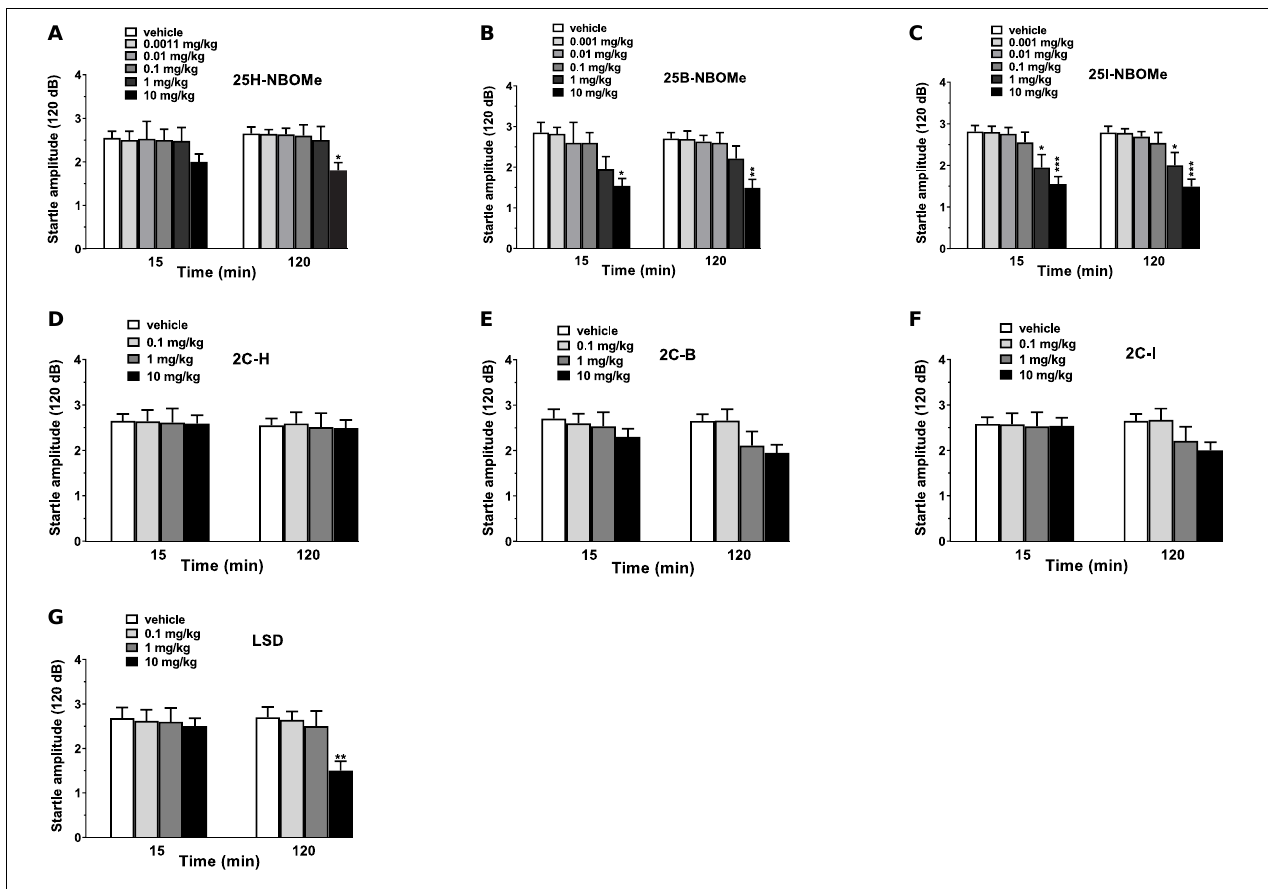
FIGURE 10 | Effect of 25H-NBOMe (0.001–10 mg/kg i.p.) (A) , 25B-NBOMe (0.001–10 mg/kg i.p.) (B) , 25I-NBOMe (0.001–10 mg/kg i.p.) (C) , 2C-H (0.1–10 mg/kg i.p.) (D) , 2C-I (0. 1–10 mg/kg i.p.) (E) , 2C-B (0.1–10 mg/kg i.p.) (F) , and LSD (0.1–10 mg/kg i.p.) (G) on startle amplitude in mice. Startle amplitude was expressed in absolute values (in dB) and the values represent the mean ± SEM of 10 animals for each treatment. The statistical analysis was performed with a one-way ANOVA followed by Bonferroni’s test for multiple comparisons. * p < 0.05, ** p < 0.01 and *** p < 0.001 vs.